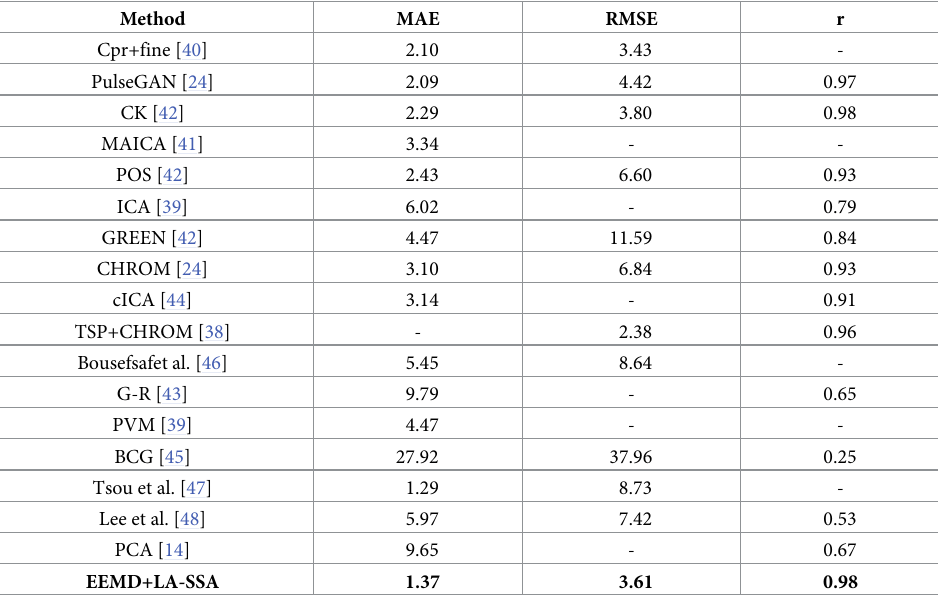
Table 5. Performance of different methods for HR estimation on database UBFC-RPPG.